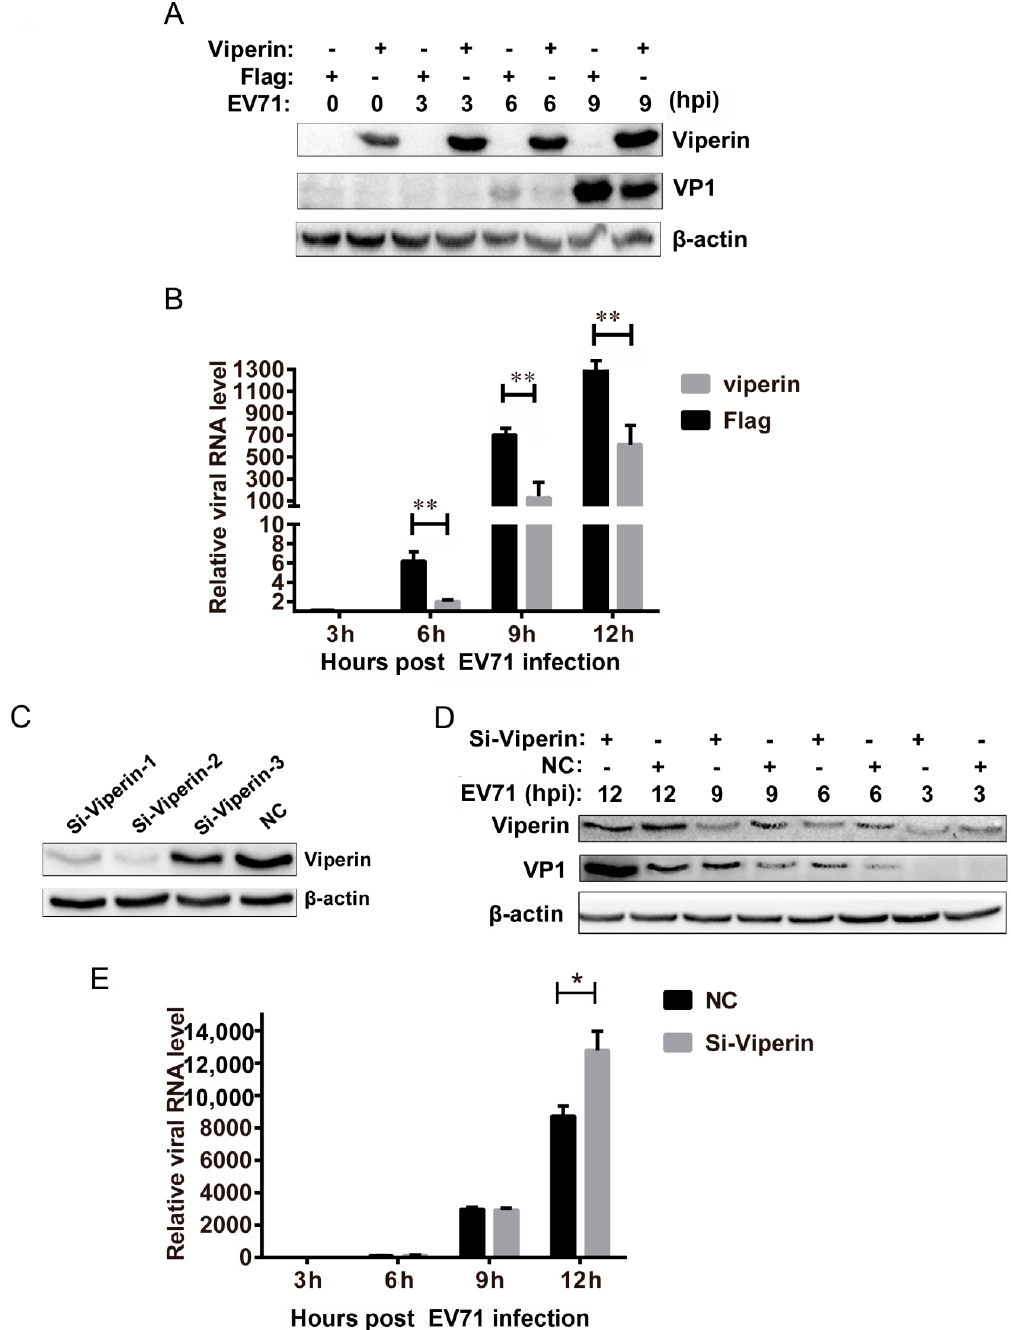
Figure 3. Viperin suppresses EVA71 replication. 293T cells were transfected with FLAG or FLAG-viperin for 24 h and then infected with EVA71 at an MOI = 1 for the indicated times. Subsequently, expression levels of VP1 were detected by ( A ) western blotting and ( B ) q-PCR with GAPDH as a control. ( C ) Synthesized siRNAs—Si-viprin-1, Si-viprin-2, and Si-viprin-3—or negative control (NC) were used to transfected 293T cells. At 24 hours post-transfection, cells were treated with type I interferon for 6 hours and lysed to determine siRNA efficiency by detecting viperin protein through western blotting. ( D ) 293T cells were then transfected with viperin siRNA or negative control for 24 h followed by infection with EVA71 at an MOI = 1 for the indicated times. Expression levels of VP1 were measured using western blotting . ( E ) q-PCR analysis with GAPDH as control to detect the viral RNA of EVA71 of viperin siRNA transfected 293T cells at indicated time points. Data are representative of at least three independent experiments performed in triplicate (mean ± SD of fold change). * p < 0.05 and ** p <